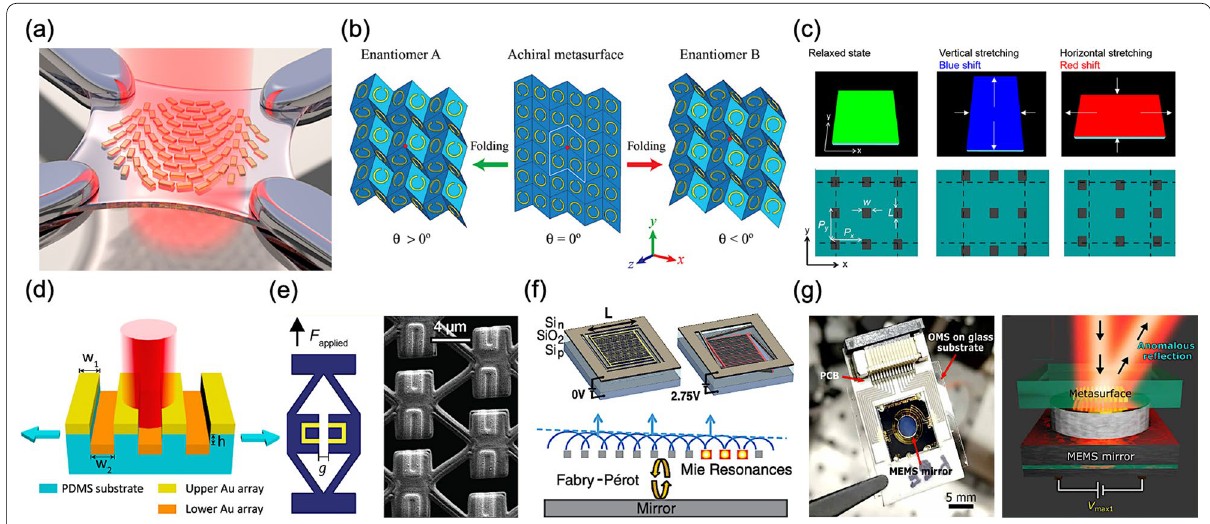
Fig. 2 Mechanically reconfigurable and tunable metasurfaces a Tunable metasurface on a stretchable substrate [52], b Construction of Miura‑ori chiral metamaterials [53], c Corresponding color changes under different stretching conditions [54], d Out‑of‑plane designed soft metasurface [55], e Mechanical metamaterials combined with optical meta‑atoms (left), Corresponding SEM image (right) [56], f Temporal color control from suspended silicon metasurfaces (top), Resonance interaction between the Fabry‑Pérot cavity and the nanowire Mie resonances (bottom) [57], and g MEMS‑based optical metasurfaces assembly (left), Schematic of demonstrated anomalous reflection by bringing the MEMS mirror (right)